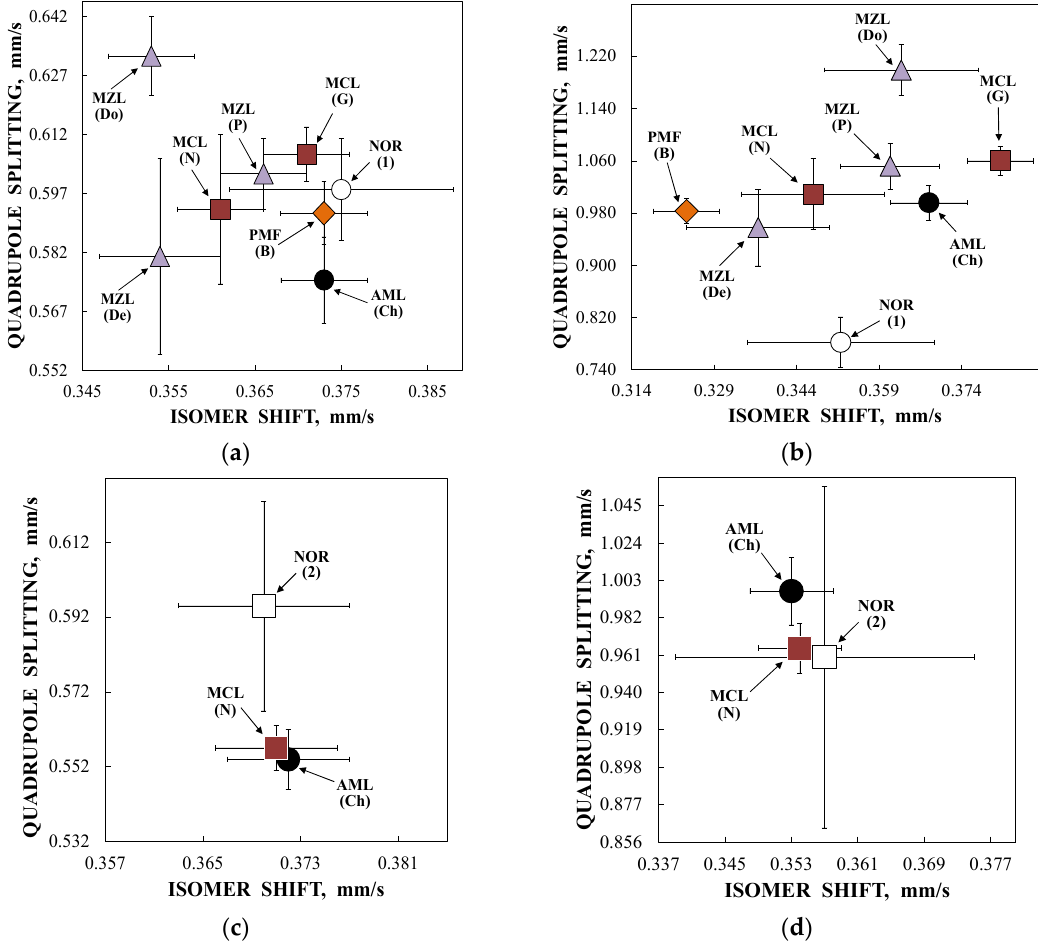
Figure 15. Plots of the 57 Fe hyperfine parameters for ferritin ‐ like components 1 ( a , c ) and 2 ( b , d ) in the Mössbauer spectra of spleen ( a , b ) and liver ( c , d ) tissues from healthy human and patients with hematological malignancies. Adapted from Ref. [59] with permission from Springer Nature: Cell Biochemistry and Biophysics, “The iron state in spleen and liver tissues from patients with hema ‐ tological malignancies studied using magnetization measurements and Mössbauer spectroscopy”,